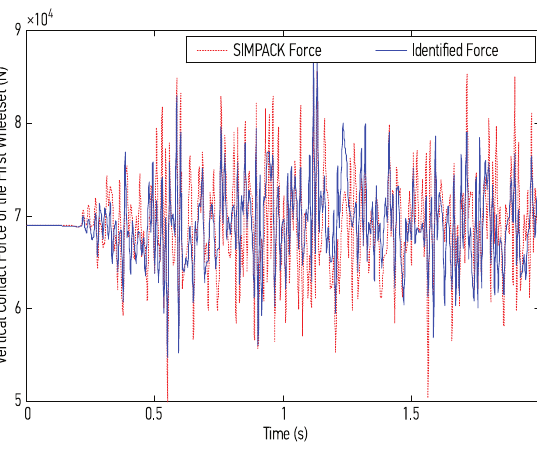
Fig. 7. Vertical wheel–rail contact force comparison for first wheel-set